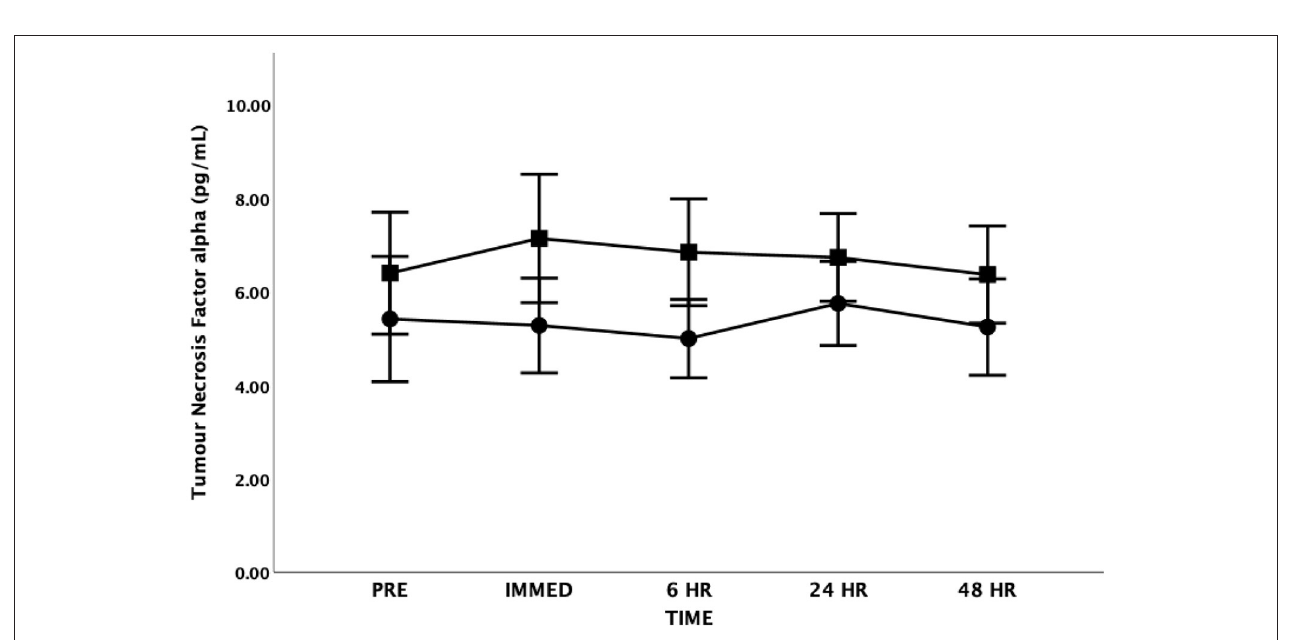
was also no interaction effect between time and group [ F (4, 48) = 0.412, p = 0.799, Partial Eta = 0.033; Observed Power = 0.137]. For CRP, the Mauchly’s Test of Sphericity was statistically significant indicating that the variances of the differences were not equal for the main effect of time.